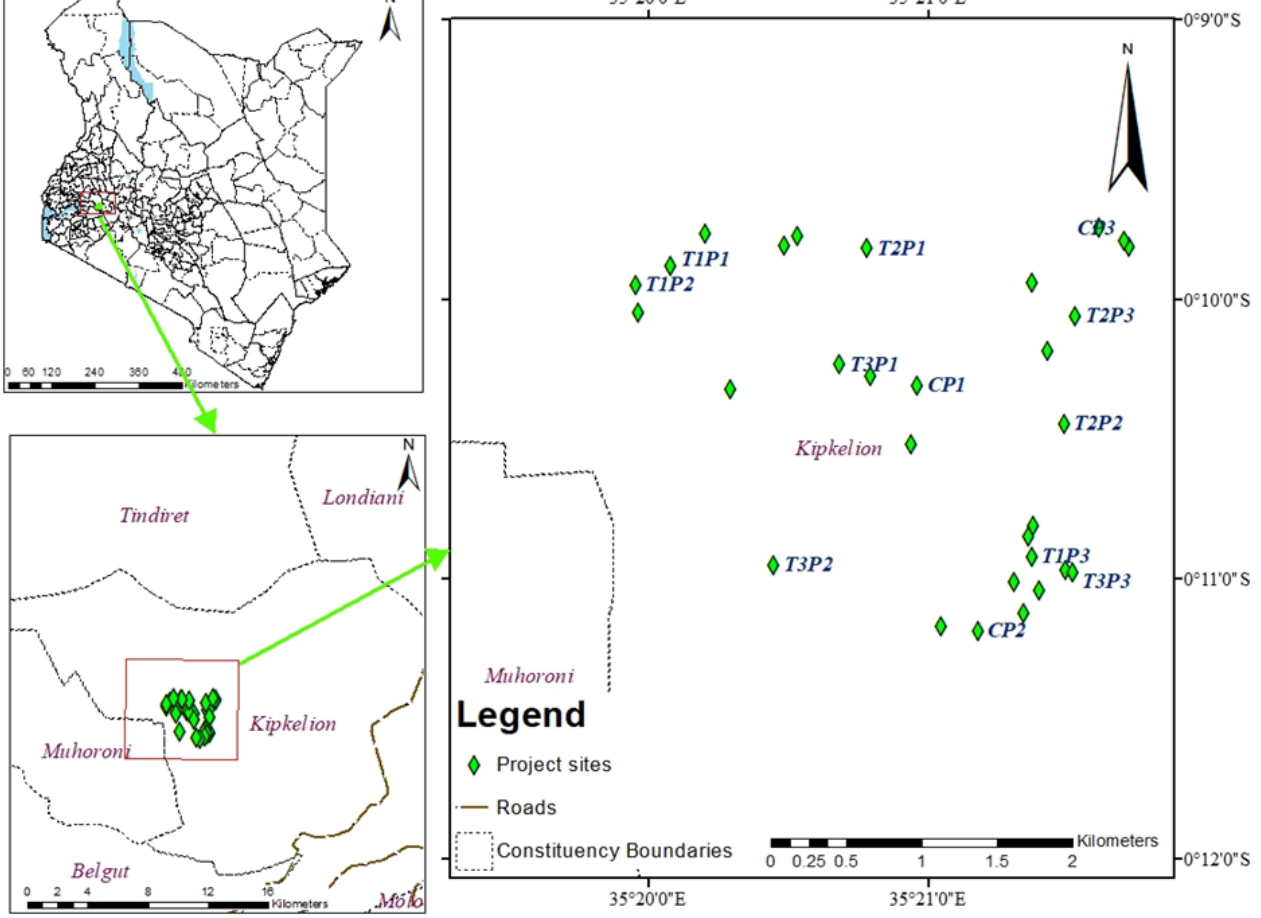
Figure 1. Project locations in Kenyan map showing coffee growing areas.